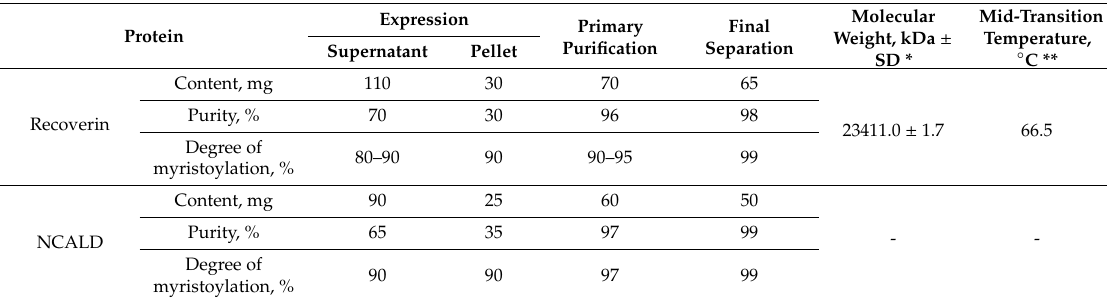
Figure 1. Solubility of neuronal calcium sensor (NCS) proteins expressed in bacteria. Western blotting of recoverin, NCS-1, neurocalcin δ (NCALD), guanylate cyclase activator protein 1 (GCAP1) and GCAP2 in soluble (`S`) and pellet (`P`) fractions obtained upon lysis of bacterial cells followed by centrifugation. The numbers in left-hand column indicate the molecular masses of protein standards in kDa. Table 1. Quantitative characteristics of NCS expression and purification. Primary purification steps: Phenyl Sepharose for NCS-1, NCALD and recoverin; Butyl Toyopearl for GCAPs. Final separation steps: Butyl Sepharose for NCS-1, GCAP1 and